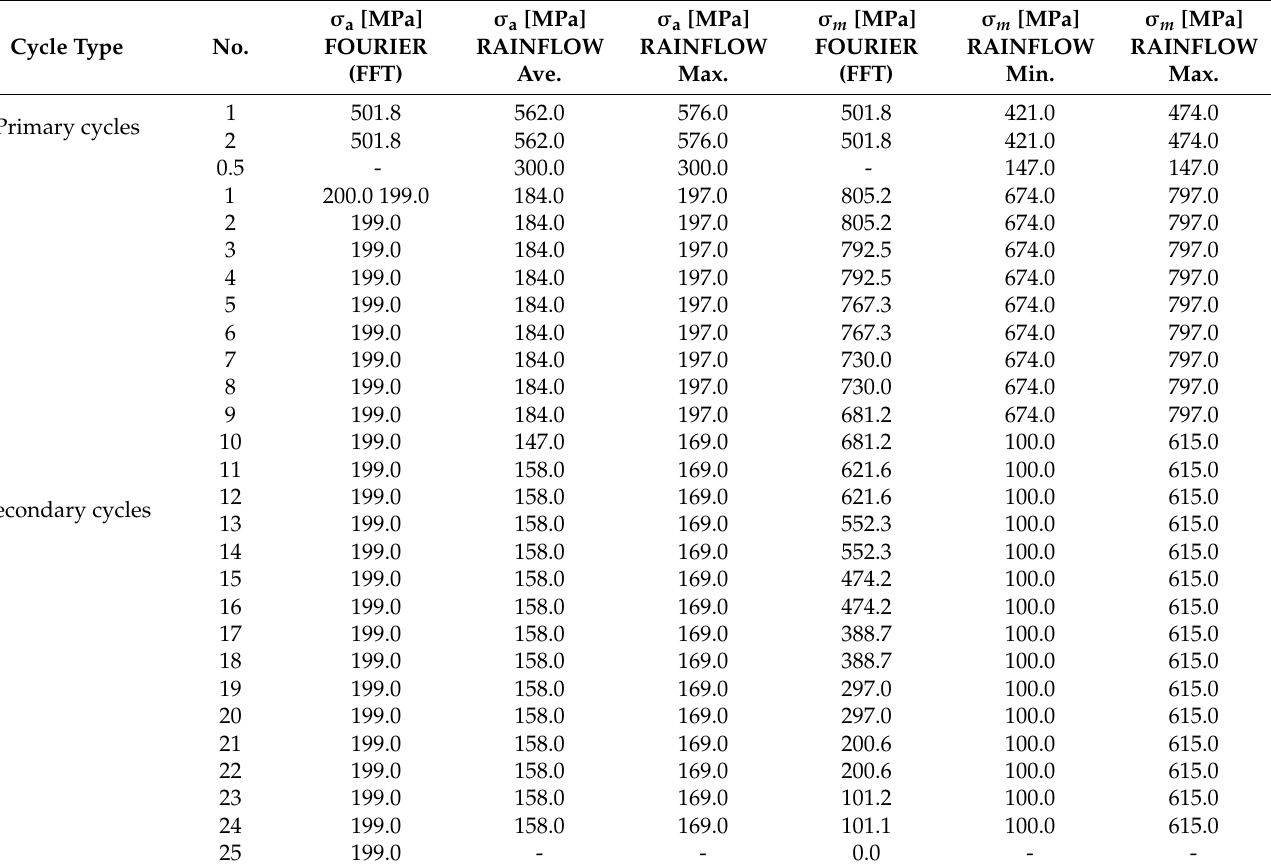
Table 1. Comparison of identified mean values and amplitudes of cycles, based on rainflow and Fourier methods for stress variation defined by